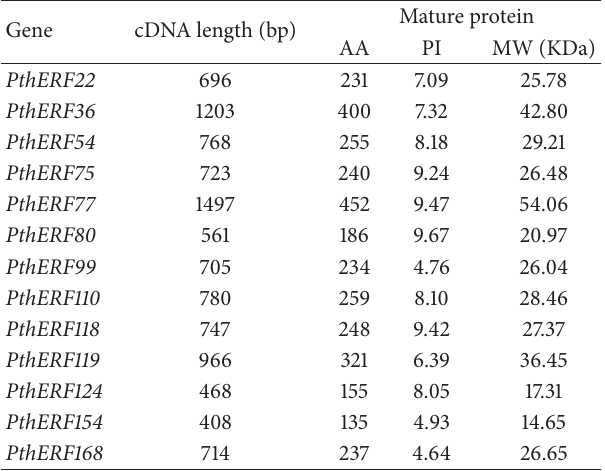
Table 2: Characteristics of the 13 PthERFs proteins.